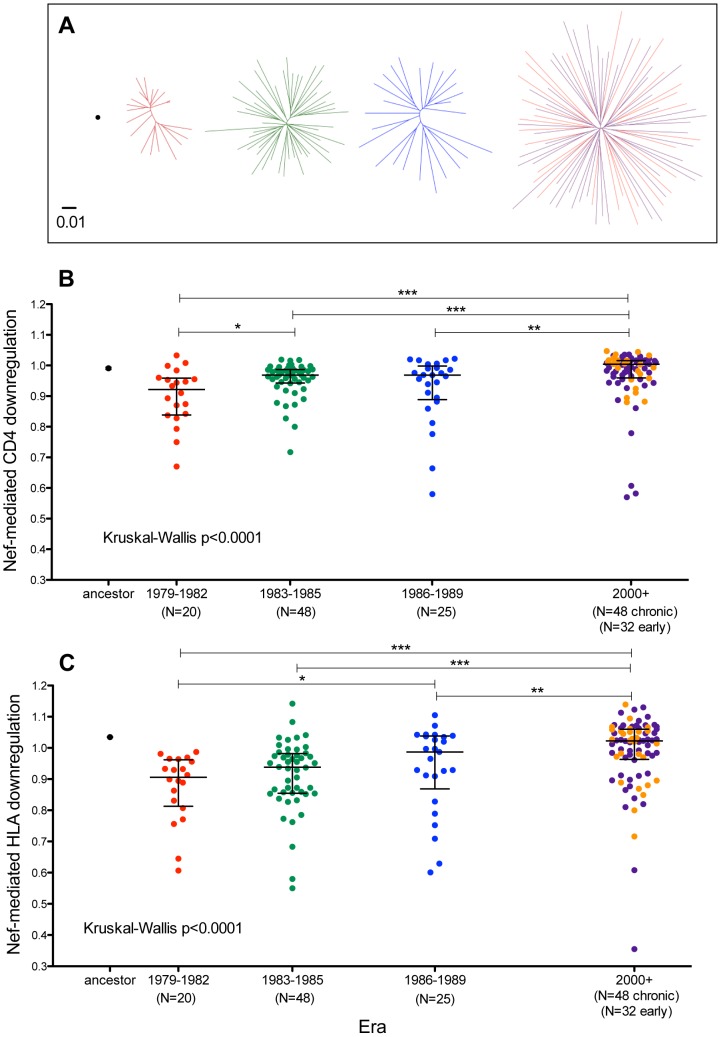
Functional implications of Nef diversification during the North American Epidemic.
Panel A: Unrooted Maximum-Likelihood phylogenies, drawn on the same distance scale, depicting the inferred ancestor (single black dot), early-historic (red, 1979–1982), mid-historic (green, 1983–1985), late-historic (blue, 1986–1989) and modern (purple: chronic-phase, orange: acute-phase, year 2000+) Nef clonal sequences from unique patients cloned into a GFP-expression vector for functional assessment. Panel B: CD4 downregulation activities of the inferred ancestral Nef sequence (mean±S.E.M. of 8 replicate measurements) and patient-derived Nef clones from various eras (one per patient, representing the mean of triplicate measurements). CD4 downregulation values are normalized to that of HIV subtype B control Nef strain SF2, such that a value of 1 indicates CD4 downregulation activity equal to that of SF2 while values>1 and <1 indicate activities higher or lower than SF2 respectively. Modern Nefs exhibited significantly higher CD4 downregulation activity compared to historic Nefs (Kruskal-Wallis p<0.0001). Panel C: SF2-normalized HLA class I downregulation activities of inferred ancestral (mean±S.E.M. of 8 replicate measurements) and patient-derived Nef sequences (one per patient, mean of triplicate measurements). Modern Nefs exhibited significantly higher HLA downregulation activity compared to historic Nefs (Kruskal-Wallis p<0.0001).